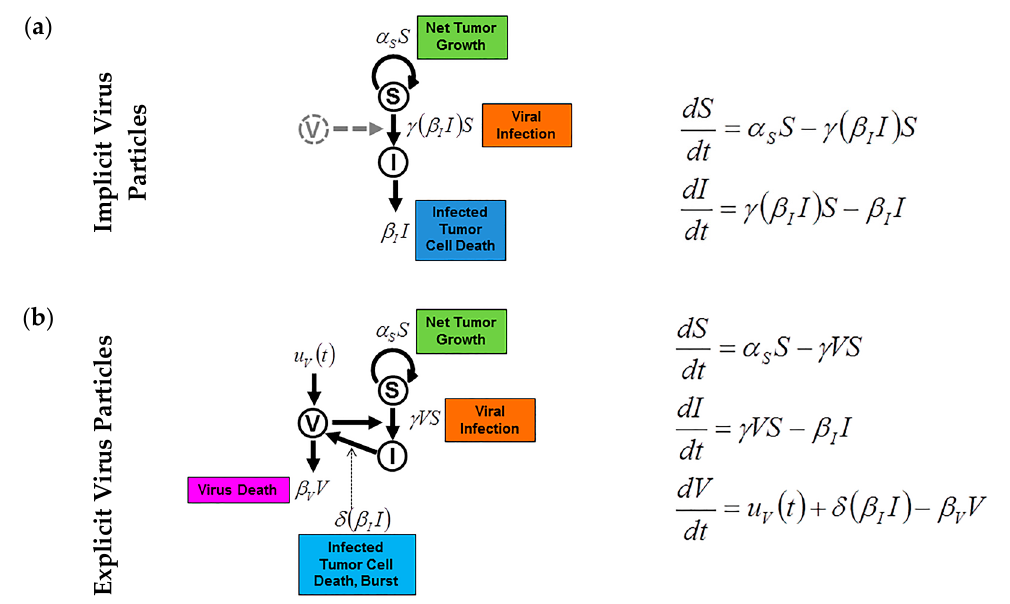
Figure 2. Simple susceptible (S) and infected (I) models with implicit ( a ) and explicit ( b ) model representations of a virus population. The β I I term ( a ) represents the population of dying infected cells. These infected cells release virus particles—not represented—upon death (also called burst [103]), hence, directly affecting the number of susceptible cells, which may become infected, γ ( β I I ) S . In explicit virus systems ( b ), the β I I term is commonly described as explicitly affecting the number of virus particles ( δ ) as opposed to the virus being modeled implicitly from its effects on the S and I populations. Consequently, the viral infection term is γ VS . The term U V ( t ) simulates the effect of oncolytic virotherapy, a number of virus particles administered at time t . Novozhilov et al. warns that mass-action, the assumption that the rate is proportional to the product of the variables, may only be acceptable when the S and I populations are close in value, S ≈ I [95].